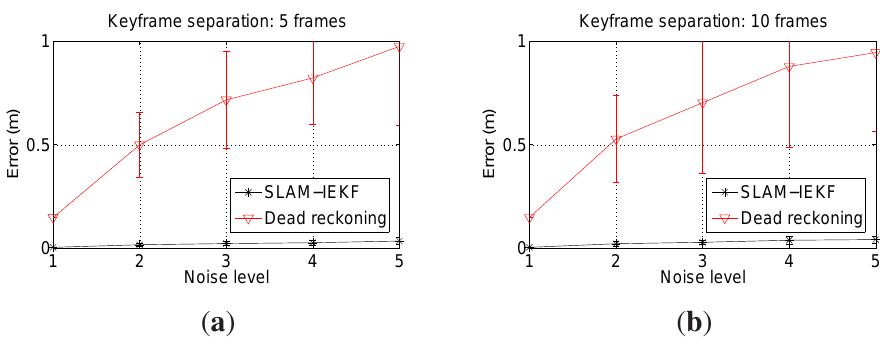
Figure 7. Errors in meters and 2 σ bound. Noise levels represent the covariance of the synthetic zero-mean Gaussian noise added to odometry, ranging from Noise Level 1 , Σ , Σ ( [Σ ] = [0 , 0 , 0] ) to Noise Level 5 ( [Σ x y θ